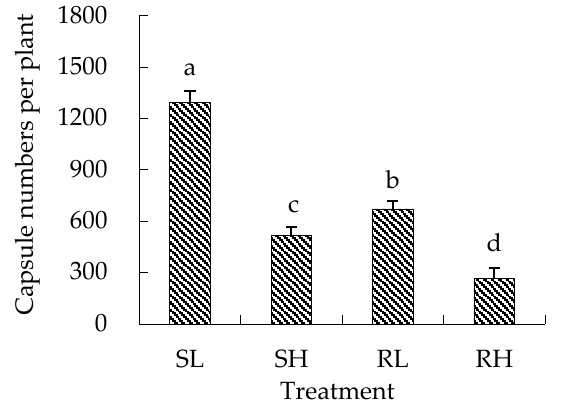
Figure 3. Number of capsules (mean ± standard error) per eared redstem plant at 141 DAS. The letters L and H refer to low and high eared redstem densities, respectively. The letters S and R refer to BSM-susceptible and BSM-resistant biotypes, respectively. Different letters above columns indicate significantly different means ( p <